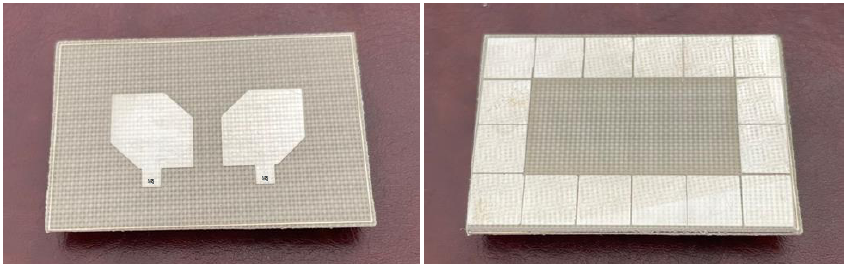
Figure 11. Photographs of fabricated proposed MIMO CP antenna.